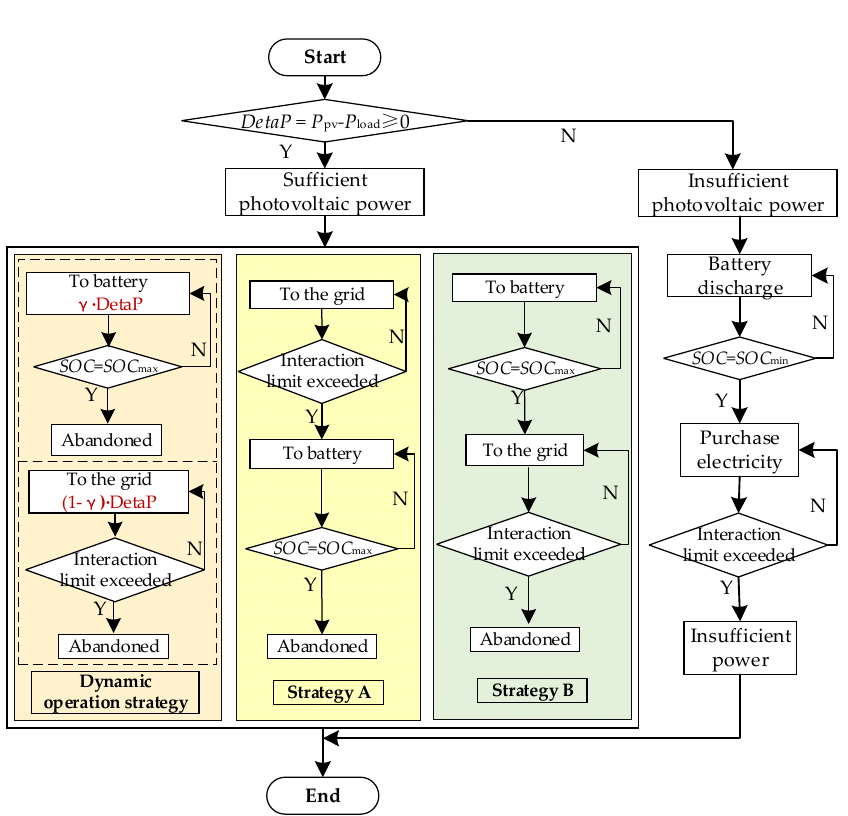
Figure 2. System operation strategy in the grid-connected scenario. P pv is photovoltaic power generation; SOC is the state of charge of the batteries.